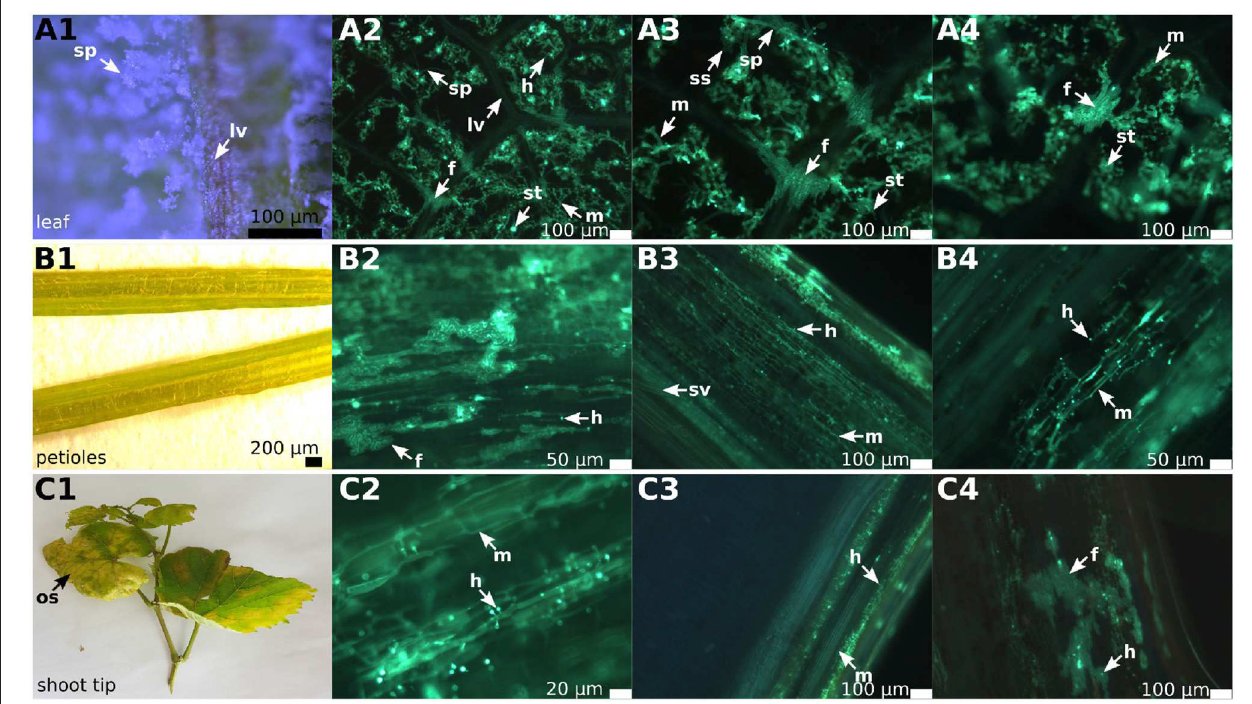
FIGURE 1 | Overview of DM infected leaves, petioles and shoot tips in grapevines. The picture shows an example of infected “Pinot blanc” leaves, petioles and shoot tips. The left row of this panel shows a binoscopic overview (1) of the indicated plant organ, followed by three microscopic pictures (2–4) to the right. The samples were treated with KOH, stained with aniline blue and analyzed by epifluorescence microscopy. (A1–A4) Leaf segments of the susceptible grapevine infected with P. viticola . The binoscopic image (A1) shows the typical growth of the pathogen on the lower side of the leaf after 6 days of pathogen development. The microscopic images (A2–A4) show the clear separation of the intercostal fields by the leaf veins and the infiltrating P. viticola mycelium. On several leaf veins, the crossing by fan-shaped hyphae and the continuous spreading of the hyphae to the adjacent intercostal field is visible. (B1–B4) Not only the leaf veins can be overcome, but P. viticola also appears to spread into the petioles. The mycelium (B2–B4) shows a rather straight longitudinally extended growth along the conductive tissue and forms a multitude of haustoria. Increased numbers of fan-shaped hyphae are evident. (C1–C4) The longitudinal section through the shoots tips also shows straight longitudinal growth of mycelium (C2–C4) with enhanced formation of haustoria and the development of fan-shaped hyphae. sp, sporangiophores; m, mycelium; lv, leaf veins; f, fan-shaped hyphae; h, haustoria; sv, spiral vessel; ss, sporangia; st, stomata; os, oil spot.